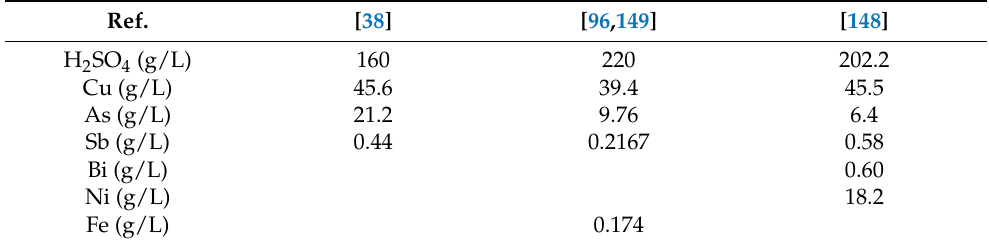
Table 11. Concentration (in g/L) of Chilean electrolytes from the electrorefining stage of copper